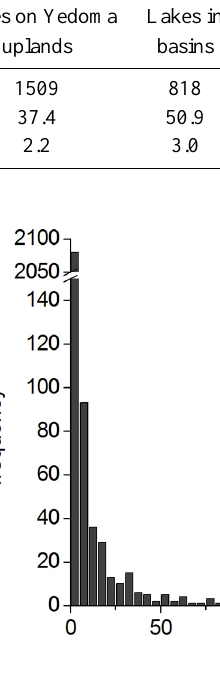
Fig. 5. Histogram of area of all water bodies in the study area (1ha=10000m 2 )